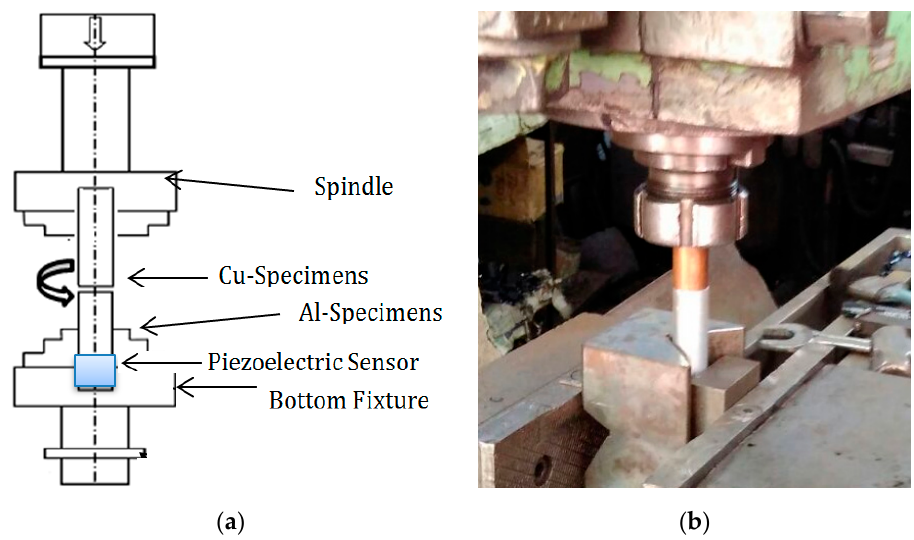
Figure 1. ( a ) Schematic layout of the friction welding process. ( b ) Experimental set-up. Table 1. Chemical composition of Al-Cu dissimilar metals used in the FW process (weight %). Metal